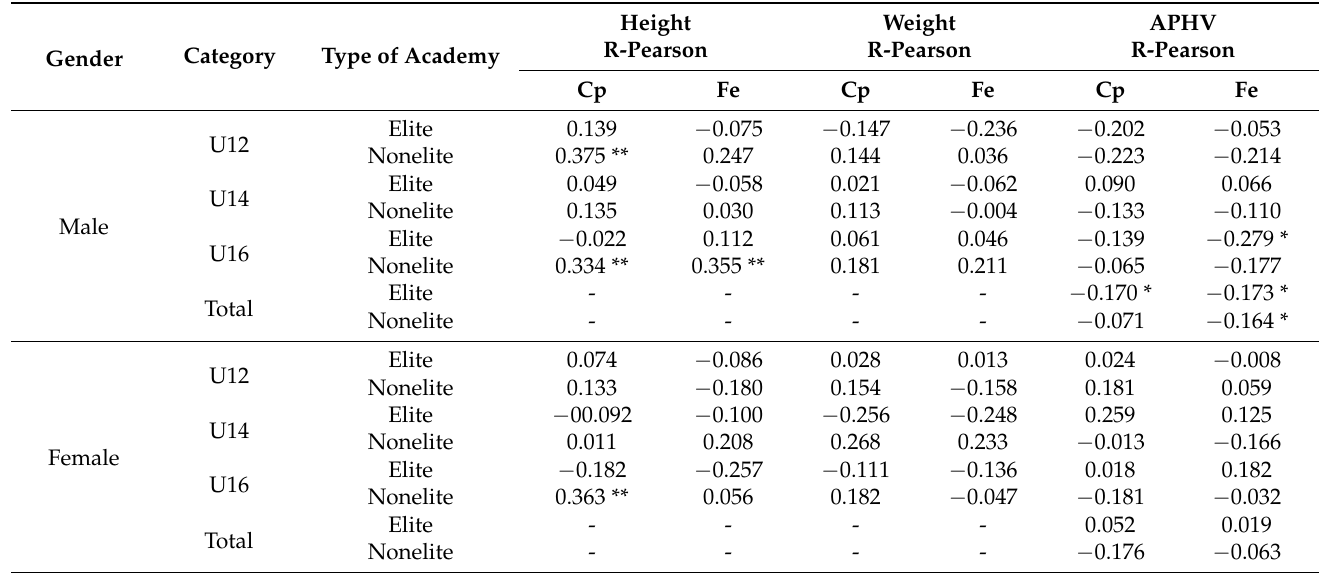
Table 6. Correlation between coach’s assessment of player performance and player anthropometry, in different age categories by type of academy and gender.